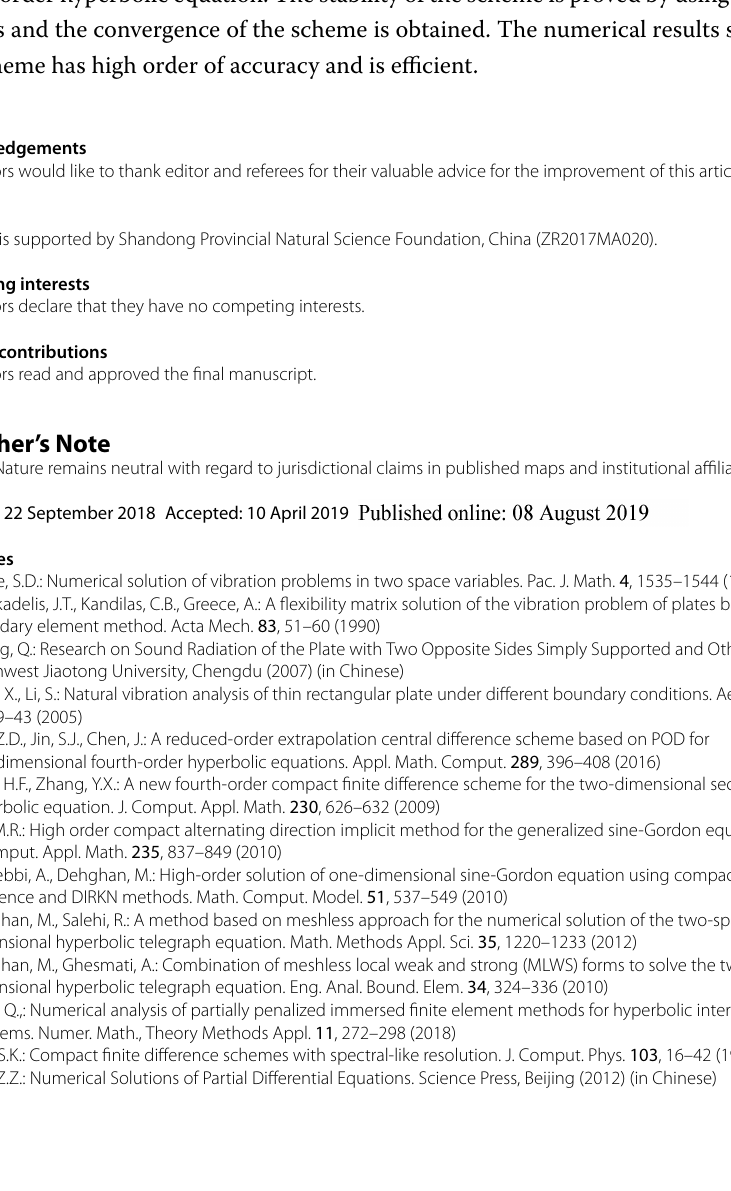
Table 12 Errors and computational orders of central difference scheme with β = 1 h